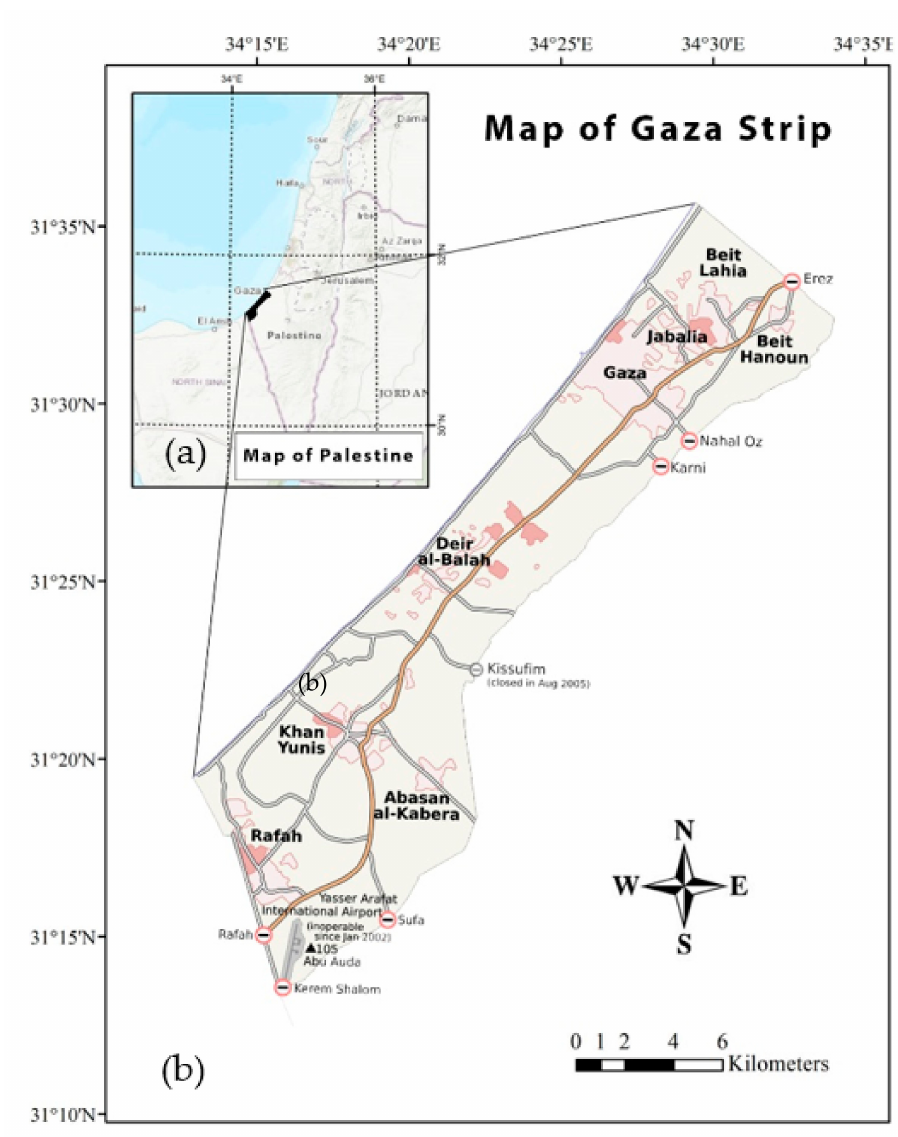
Figure 2. Map of the study area showing Palestine ( a ) and the Gaza Strip ( b